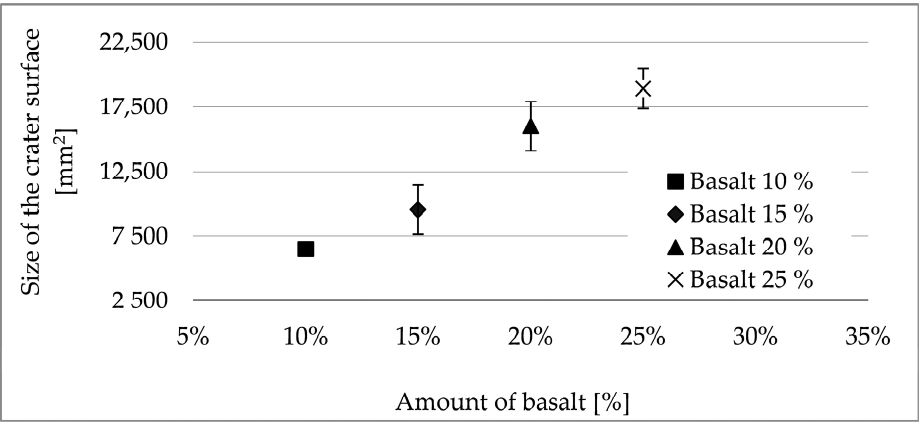
Figure 18. Size of the entrance crater area according to individual percentage substitutions.